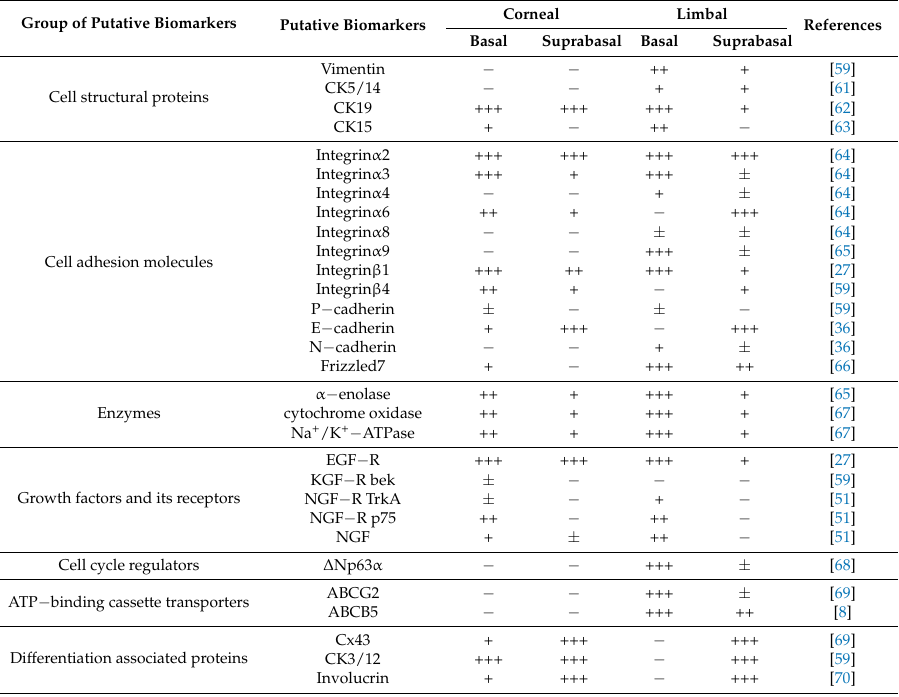
Table 2. The expression of putative biomarkers in cornea and